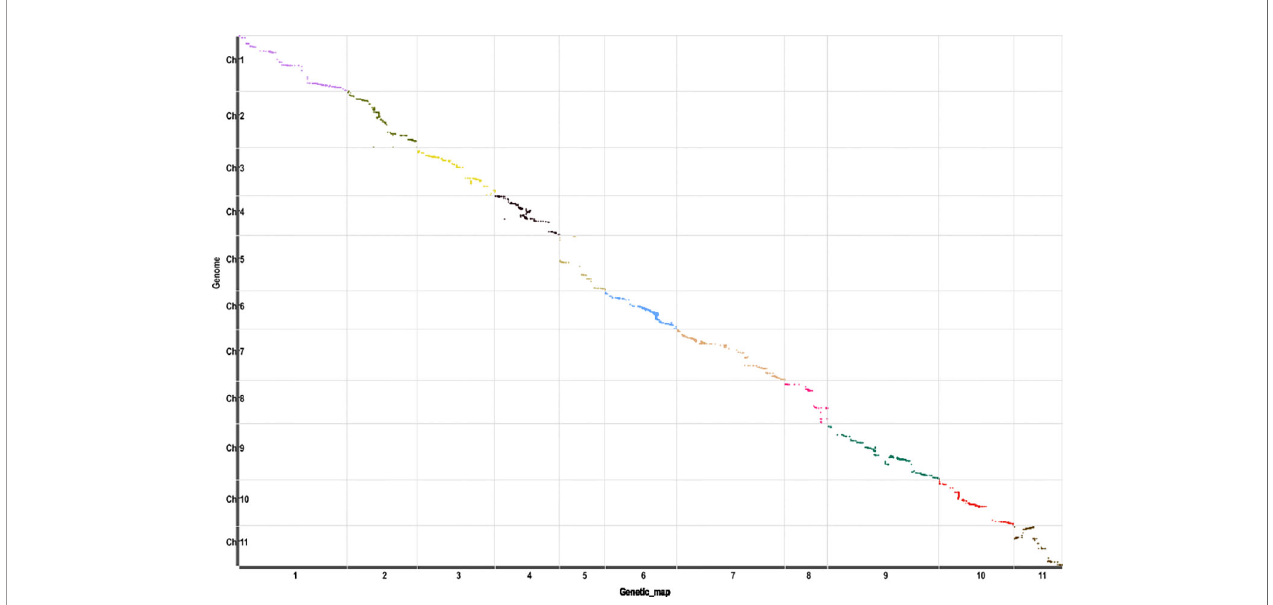
FIGURE 2 | The collinearity of 11 linkage groups with the watermelon reference genome (97103 v1). The x -axis indicates the genetic distance of watermelon linkage groups accordingly, and the y -axis represents the linearity order of the physical position in the watermelon genome. All 5,808 SNP markers in these linkage groups are plotted as dots in the fi gure. Different colors indicate different linkage groups.